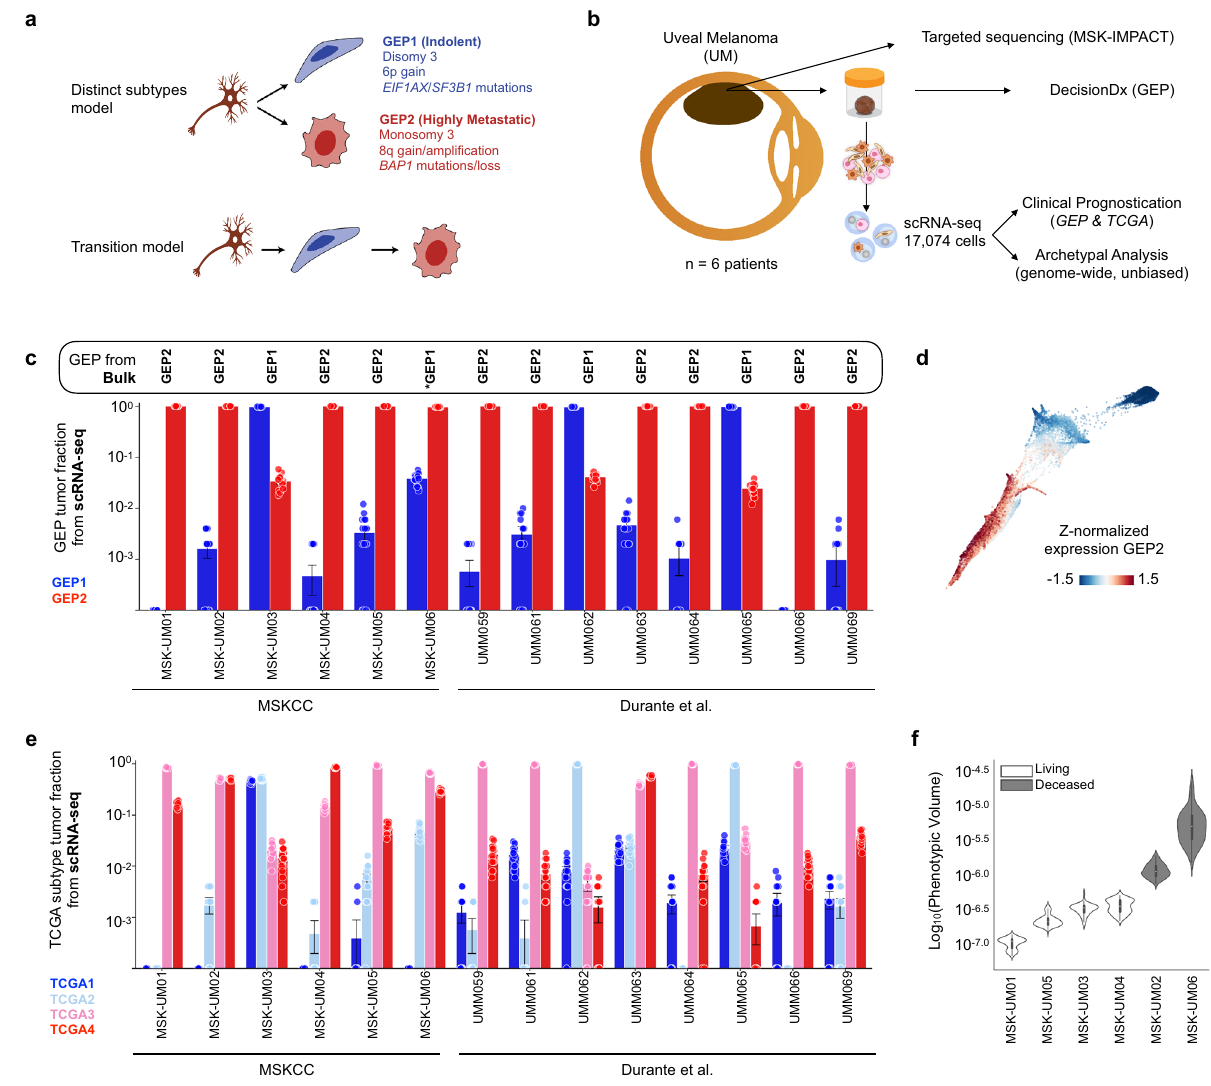
Fig. 1 Phenotypic continuum of disease progression in primary UM. a Distinguishing features of uveal melanoma (UM) with good (blue) and poor (red) prognosis; highlighting two potential models of disease progression. GEP gene expression pro fi le, TCGA the Cancer Genome Atlas. b Patient tissue pro fi ling (metadata summarized in Supplementary Table 1). Immediately following enucleation, six primary tumor specimens were obtained for clinical prognostic and single cell transcriptional pro fi ling. Targeted sequencing using the MSK-IMPACT platform was performed on the formalin- fi xed, paraf fi n embedded enucleation specimens. c Bulk GEP classi fi cation assigned to each patient according to the DecisionDx test (Castle Biosciences) (box). Individual tumor cells were likewise assigned to GEP1 (blue) vs. GEP2 (red) clinical prognostic groups according to their average expression of the GEP prognostic gene signatures using a two-component Bayesian Gaussian Mixture Model (BGMM, “ Methods ” ). The fraction of individual tumor cells assigned to GEP1 (blue) and GEP2 (red) per patient is visualized in the bar graphs, where bootstrapping was used to correct for number of cells per patient (bar, mean; whiskers, 95% con fi dence intervals, 500 tumor cells sampled over n = 20 random subsets of the data). Asterisks, highlight a patient in which there was a discrepancy between DecisionDx bulk classi fi cation and the majority GEP classi fi cation prescribed by our single cell analysis of resected tumors. Notably, this patient (MSK-UM06) experienced metastatic progression and succumbed to their disease within six months of diagnosis (Supplementary Table 1). Intra-tumoral prognostic heterogeneity was validated in a second, independent cohort recently published by Durante et al. 24 . d Force-directed layout of all patient tumor cells colored by z-normalized imputed expression of the average GEP2 gene signature. e Individual tumor cells were likewise assigned to one of the four TCGA molecular subtypes of UM according to their average expression of characteristic genes using a four-component BGMM (Methods) in our cohort and a second, independent cohort recently published by Durante et al. 24 . The fraction of individual tumor cells assigned to TCGA subtype 1 (dark blue), subtype 2 (light blue), subtype 3 (pink) and subtype 4 (red) per patient is visualized in the bar graphs, where bootstrapping was used to correct for number of cells per patient (bar, mean; whiskers, 95% con fi dence intervals, 500 tumor cells sampled over n = 20 random subsets of the data). f Violin plots showing the distribution of intra-patient phenotypic volume (de fi ned as the pseudo-determinant of the gene expression covariance matrix, detailed in “ Methods ” ), controlled for number of cells and labeled by patient status (alive vs. deceased). Distributions represent 100 random subsamples from the data ( n = 150 cells per patient). Overlaid bar and whisker plots re fl ect the mean and interquartile